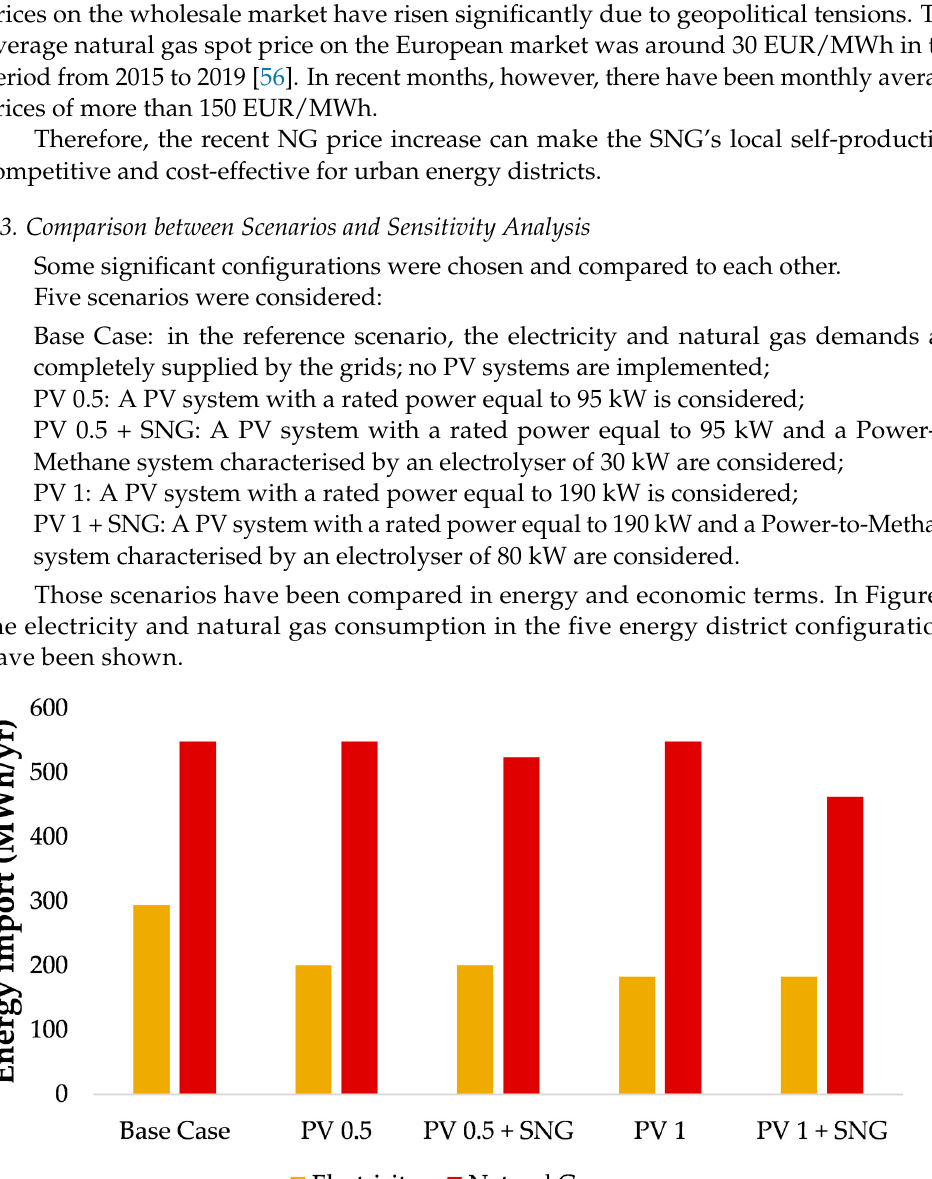
Figure 10. Annual costs of the energy district in the five scenarios. The implementation of the photovoltaic arrays along with the Power-to-Methane strategy makes it possible to reduce the urban district overall energy consumption and, at the same time, to decrease the households’ annual expenditures. Indeed, it is possible to greatly reduce both electricity and gas consumption by ex- ploiting almost all the energy produced on site by the PV system. The effect of the Power-